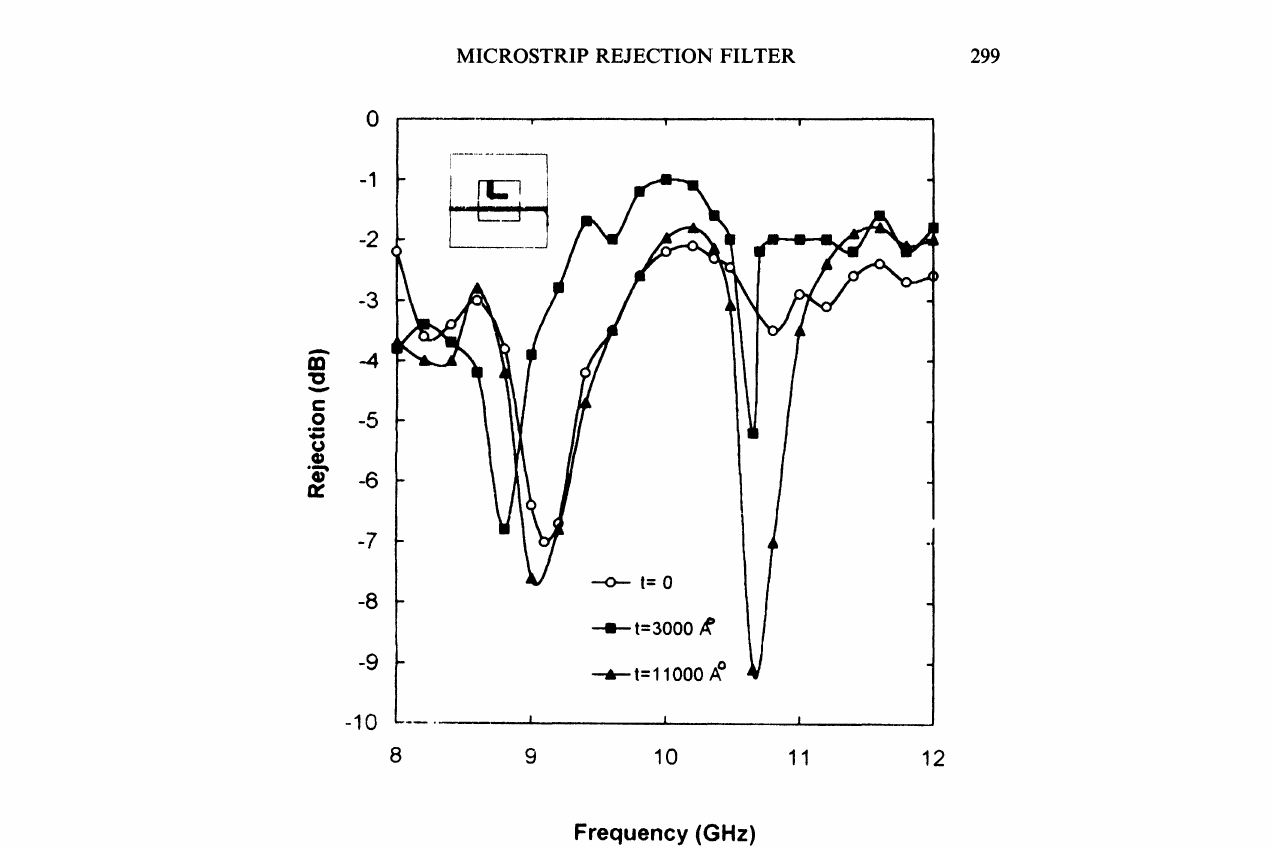
Frequency (GHz) Frequency versus rejection filter without and with overlay of thin film FIGURE TiO2.